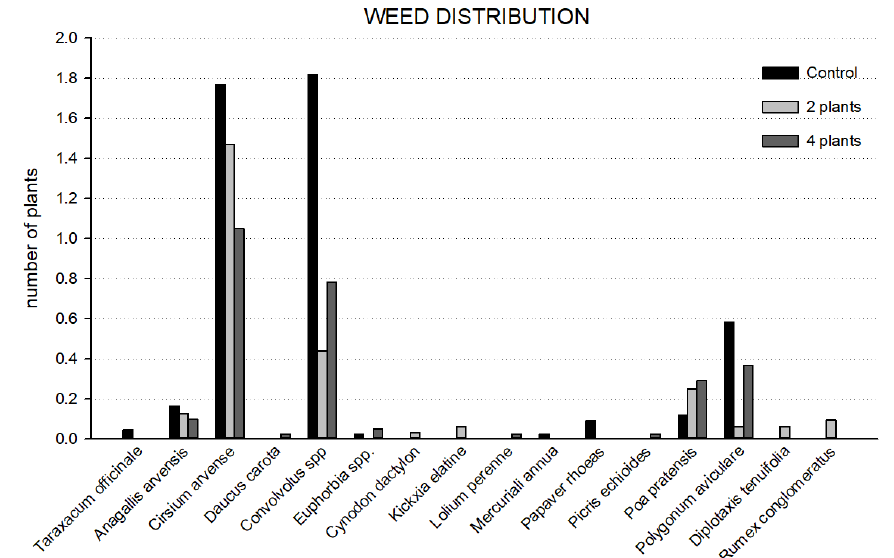
Figure 5. Number of plants per each weed species (distribution) found in 0.25 m 2 in the row (mean ± SD).